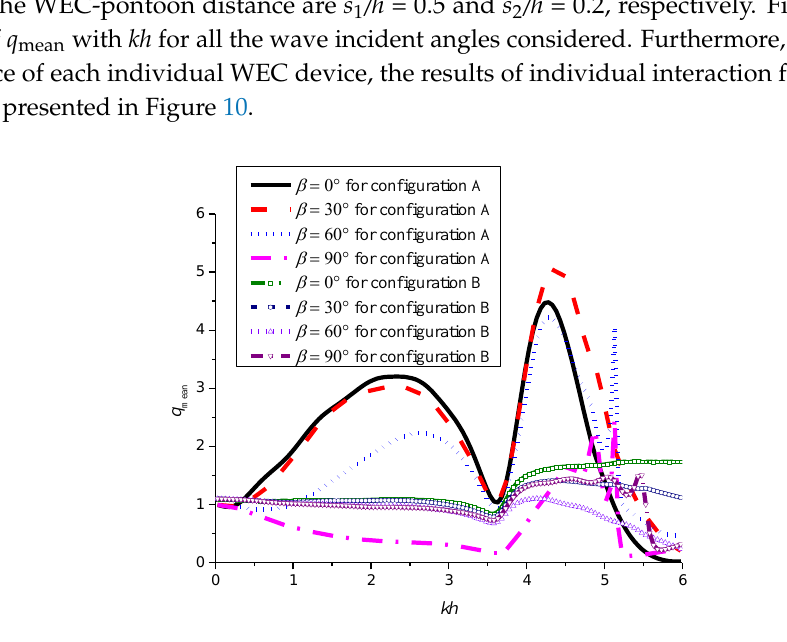
Figure 9. Variations of q mean with kh for WEC array with (configuration A) and without (configuration B) pontoon with different wave incident angles.